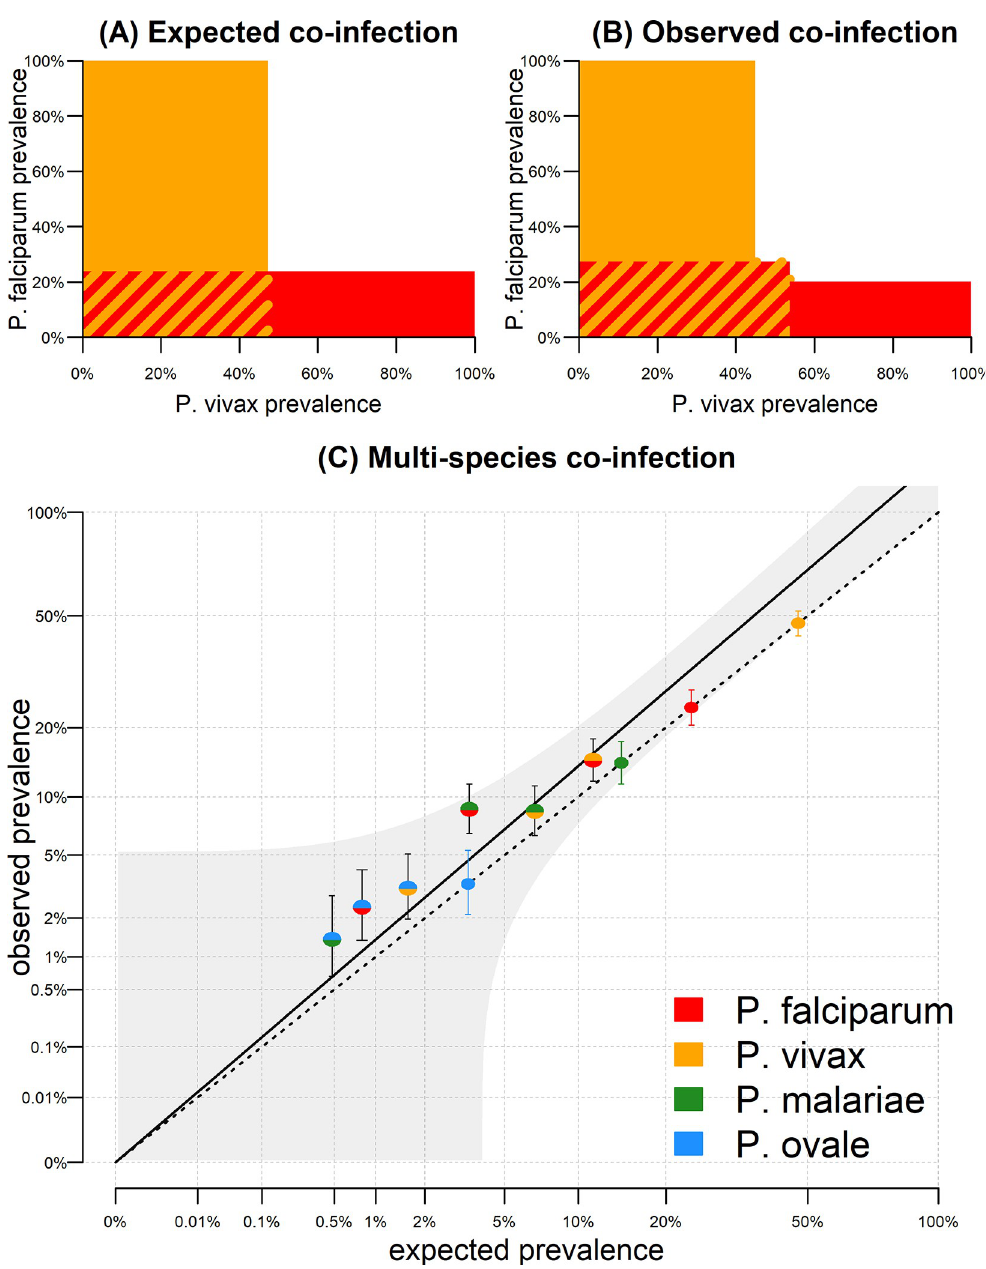
Fig 2. Excess asexual parasite co-infection in pre-treatment samples. (A) In the pre-treatment samples, Pf asexual prevalence was 23.8% (120/504) and Pv asexual prevalence was 47.4% (239/504). If these parasites were randomly distributed, we would expect co-infection prevalence of 0.238 � 0.474 = 11.3% (red and yellow striped region). (B) Co- infection prevalence of 14.7% (74/504) was observed, in excess of what is expected by random mixing. (C) Expected versus observed co-infection prevalence for the six pairwise combinations of asexual parasites. The dashed line represents the scenario where observed co-infection prevalence equals expected prevalence. Mono-coloured points denote observed prevalence rates of the four species. The multi-coloured data points fall above this line. The solid line denotes a regression model fitted through these points, with 95% confidence intervals shown in grey.